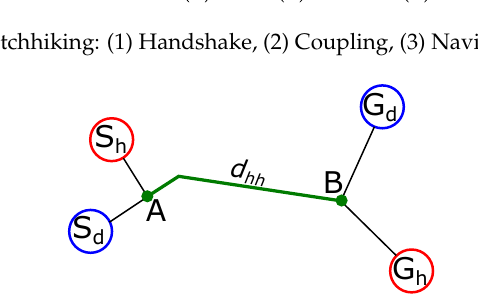
Figure 3. Hitchhking is allowed if the common path d hh is longer than a threshold distance ( T dhh ). Point A is the handshake and coupling location, while point B is the decoupling